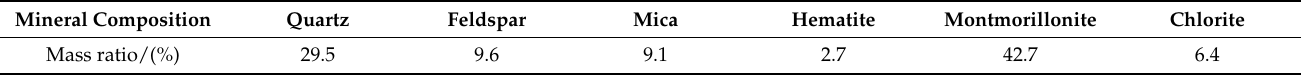
Table 2. XRD analysis results of natural red-bedded soft rock.